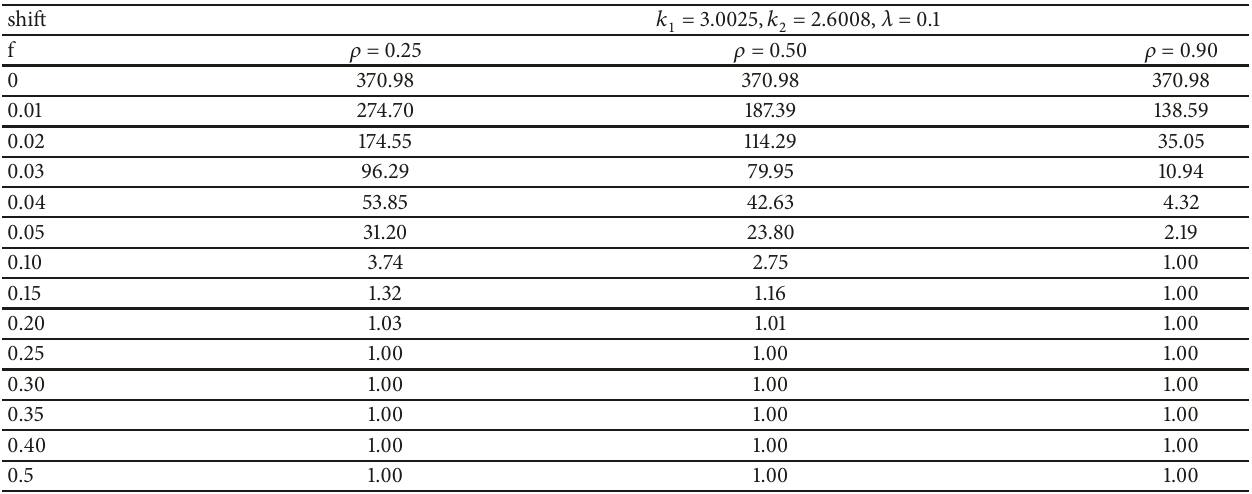
Table 10: ARLs for proposed repetitive EWMA-RSS control chart using Khan et al. [8] exponential ratio-type estimator, when 𝑟 𝑜 is 370. shift